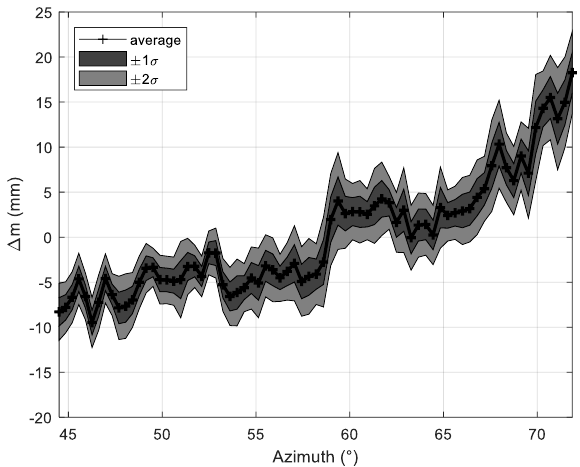
Figure 9. Statistical characteristics of G22 data in all no-rain days.